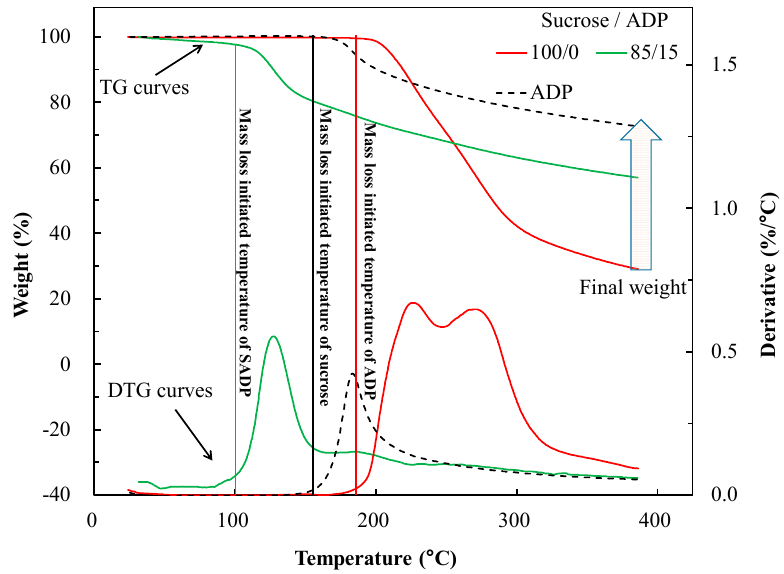
Figure 5. TG and DTG curves of sucrose (100/0), ADP (0/100), and uncured SAPD adhesive (85/15).